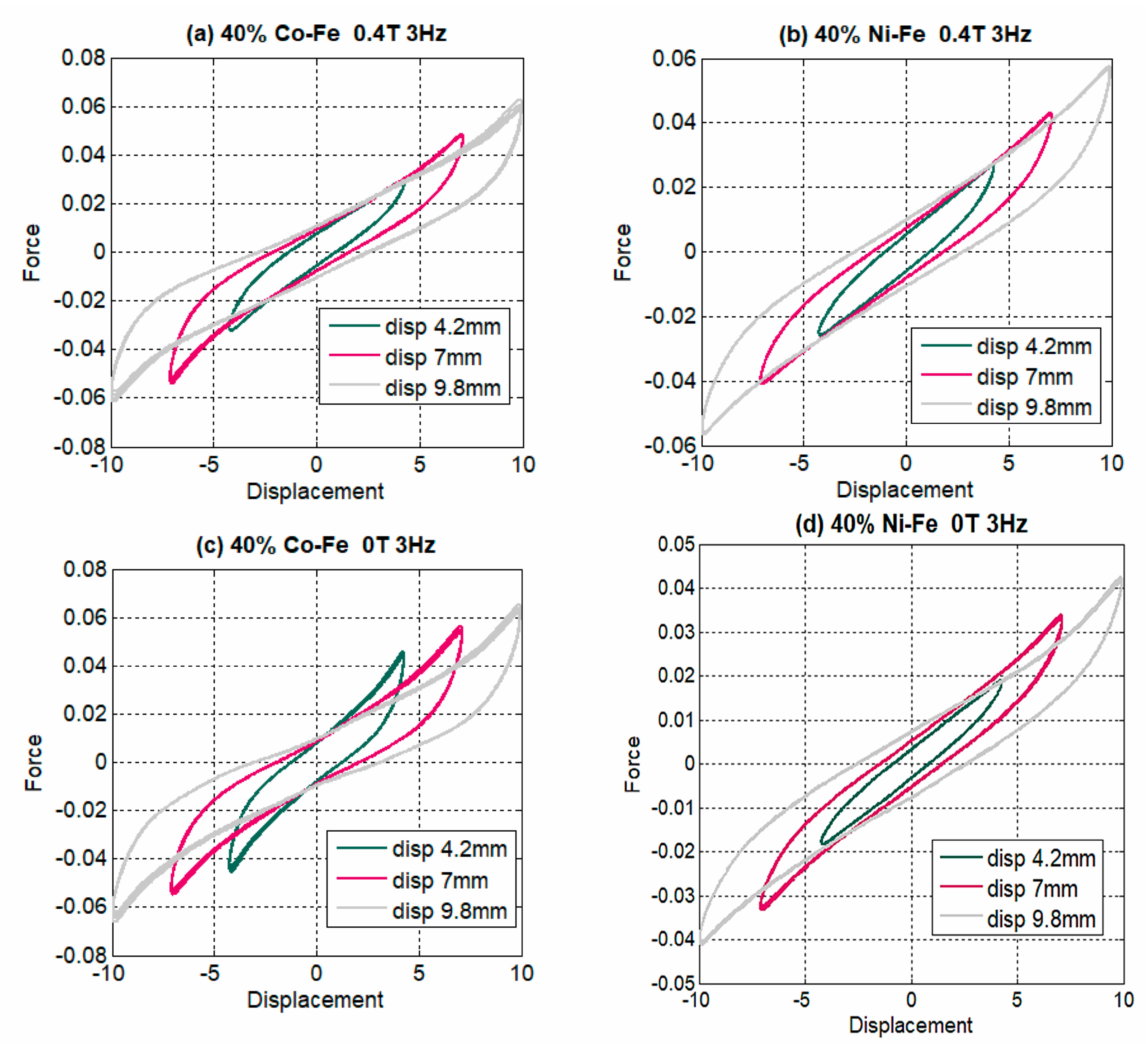
Figure 6. Comparison of amplitude effect on 40 % filler at maximum and minimum flux ( a ) 40% Co-Fe at 0.4 T ( b ) 40% Ni-Fe at 0.4 T ( c ) 40% Co-Fe at 0 T ( d ) 40% Ni-Fe at 0